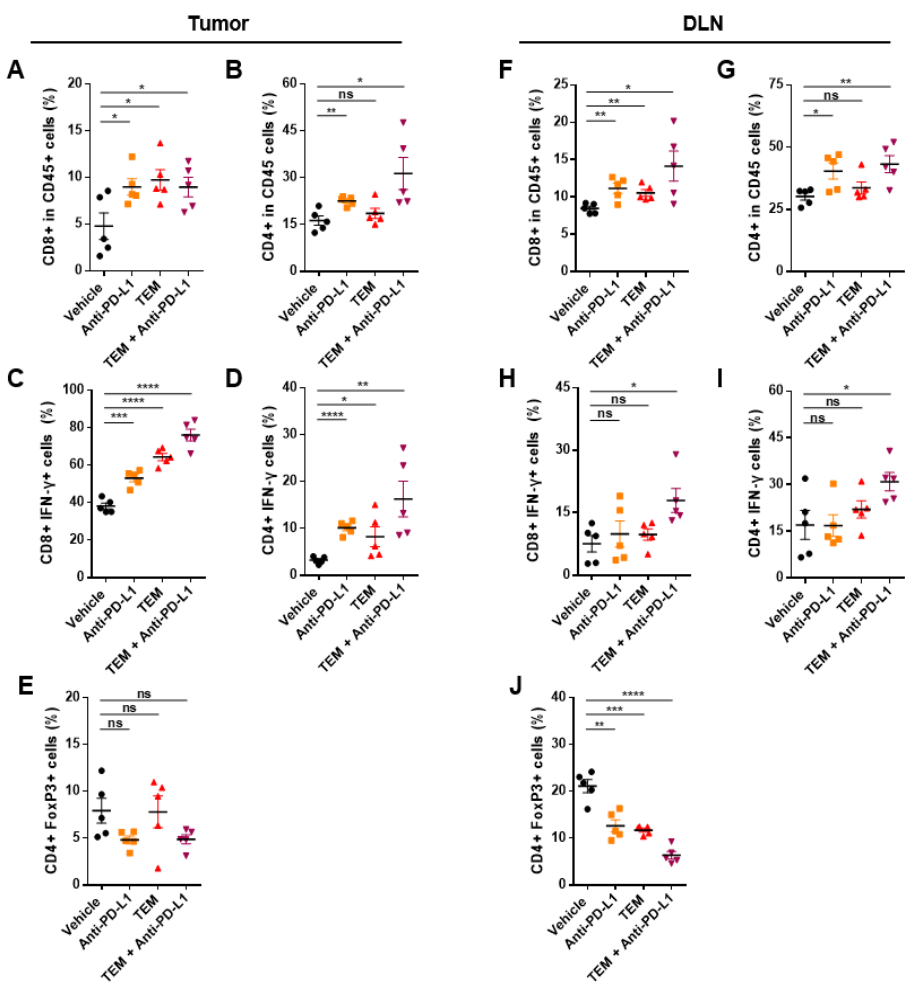
Figure 5. Combined administration of TEM and anti-PD-L1 antibodies increases the immune response in the 4T1 tumor model. ( A – J ) Flow cytometric analysis of the T lymphocytes in tumors and draining lymph nodes (DLNs) ( n = 6). The proportions of ( A ) CD8 + cells and ( B ) CD4 + cells in the CD45 + cells in the tumor. The proportions of IFN- γ producing cells among the ( C ) CD8 + cells and ( D ) CD4 + cells in the tumors. The proportions of ( E ) CD4 + FoxP3 + cells in the tumors. The proportions of ( F ) CD8 + cells and ( G ) CD4 + cells of the CD45 + cells in the DLNs. The proportions of IFN- γ cells among the ( H ) CD8 + cells and ( I ) CD4 + cells in the DLNs. The proportions of ( J ) CD4 + FoxP3 + cells in the DLNs. The data are presented as means ± standard error of the mean (SEM). * p < 0.05, ** p < 0.01, *** p < 0.001, and **** p < 0.0001, respectively; ns, not significant.